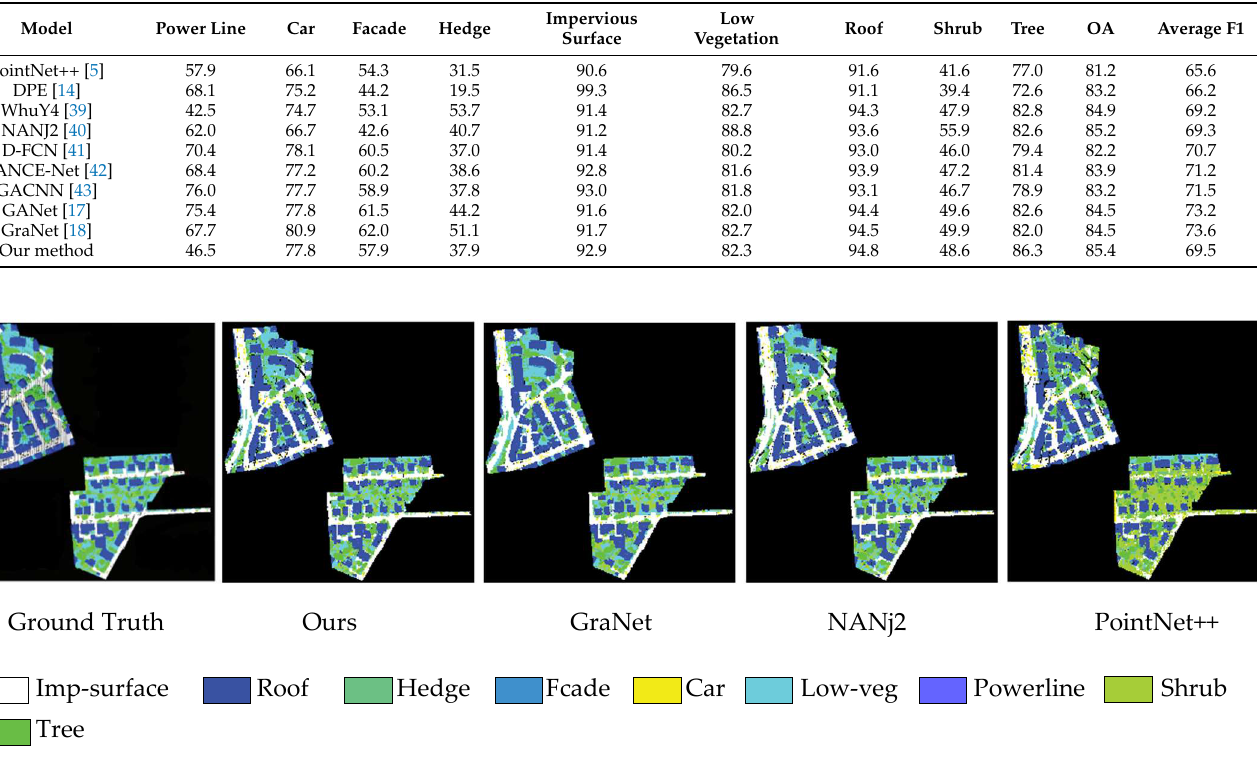
Figure 8. Visualization results produced our method and other models.